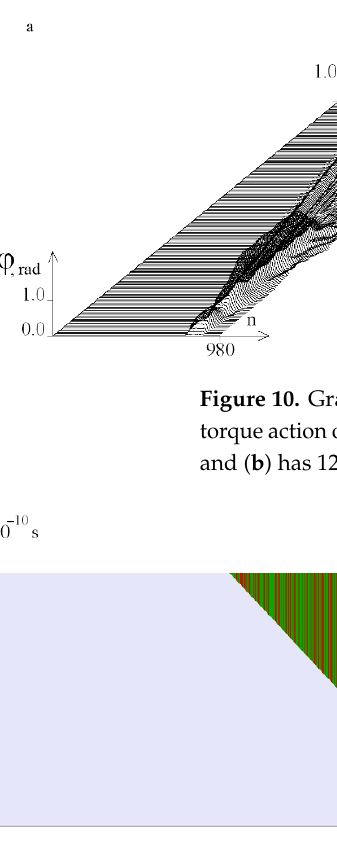
Figure 9. Graphs of the probability (in percent) of OS occurrence under the action of a torsion moment localized on the segment [1, 100] (thin line) and on the segment [101, 200] (thick line).